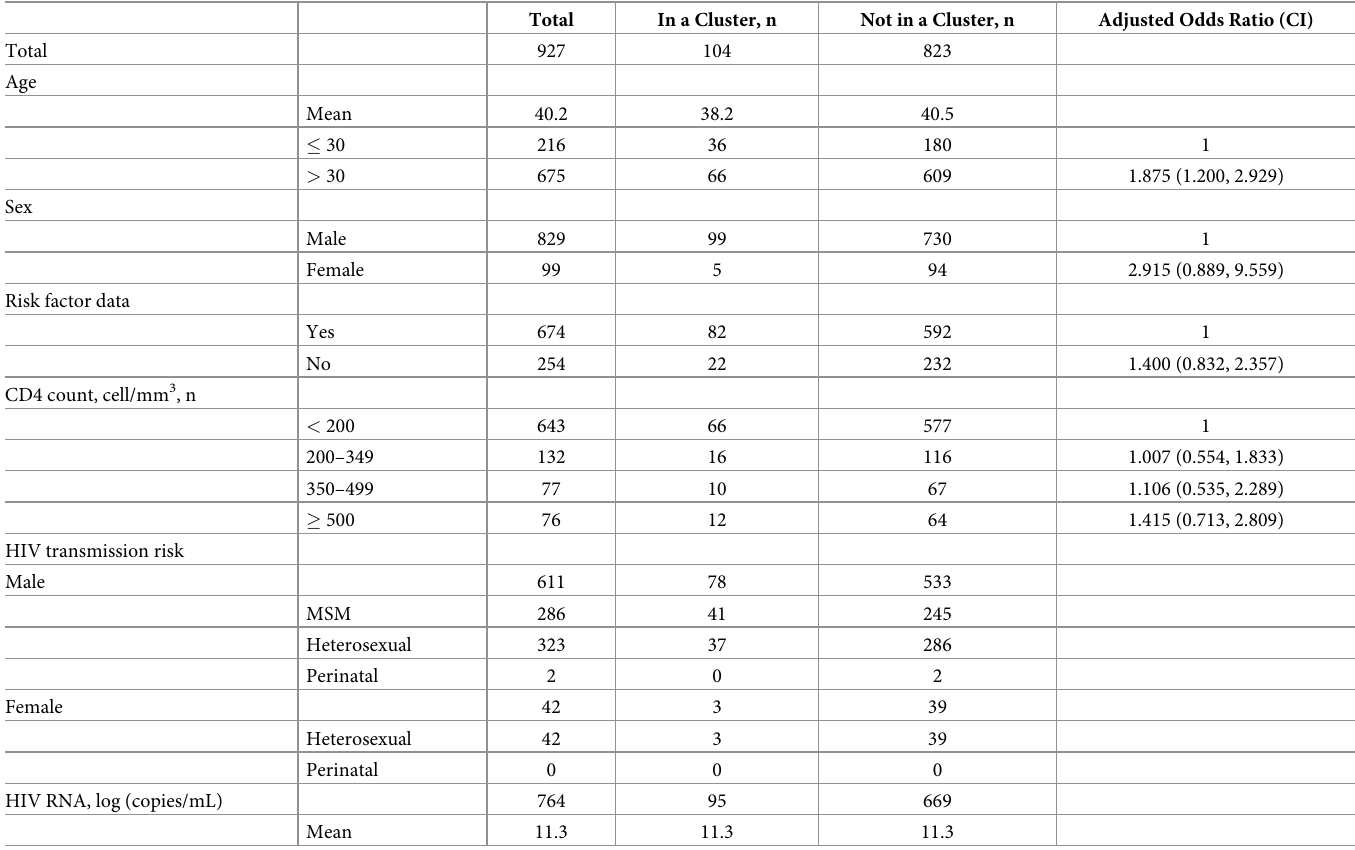
Table 3. Factors associated with cluster membership: full sample analysis (n =